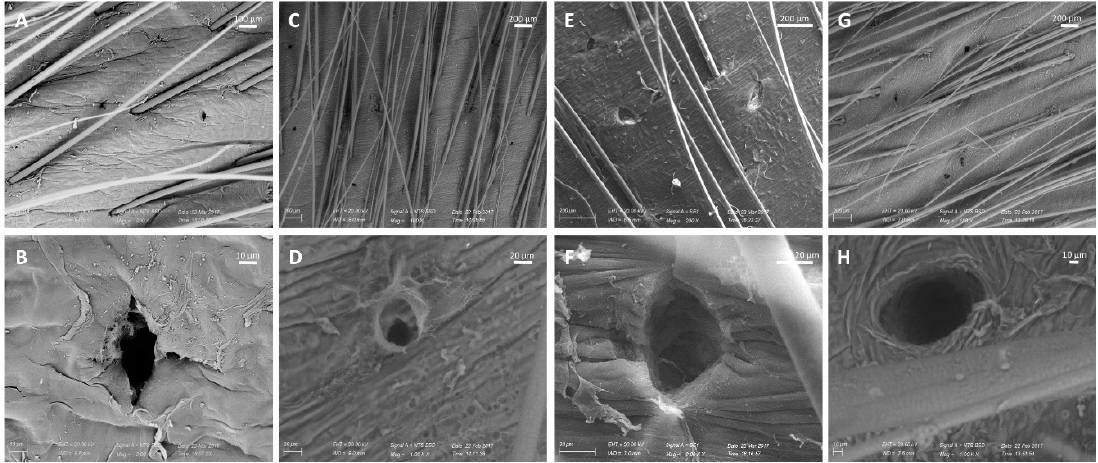
Figure 3. SEM visualization of skin pores after microneedle rolling in four directions with the DermaQ ® with needle lengths of 0.5 mm ( A – D ) or 1.5 mm (E–H). Images were acquired in HV mode (( A , E ) 200× magnification and ( B , F ) 2000× magnification) or LV mode (( C , G ) 100× magnification and ( D , H ) 1000× magnification).